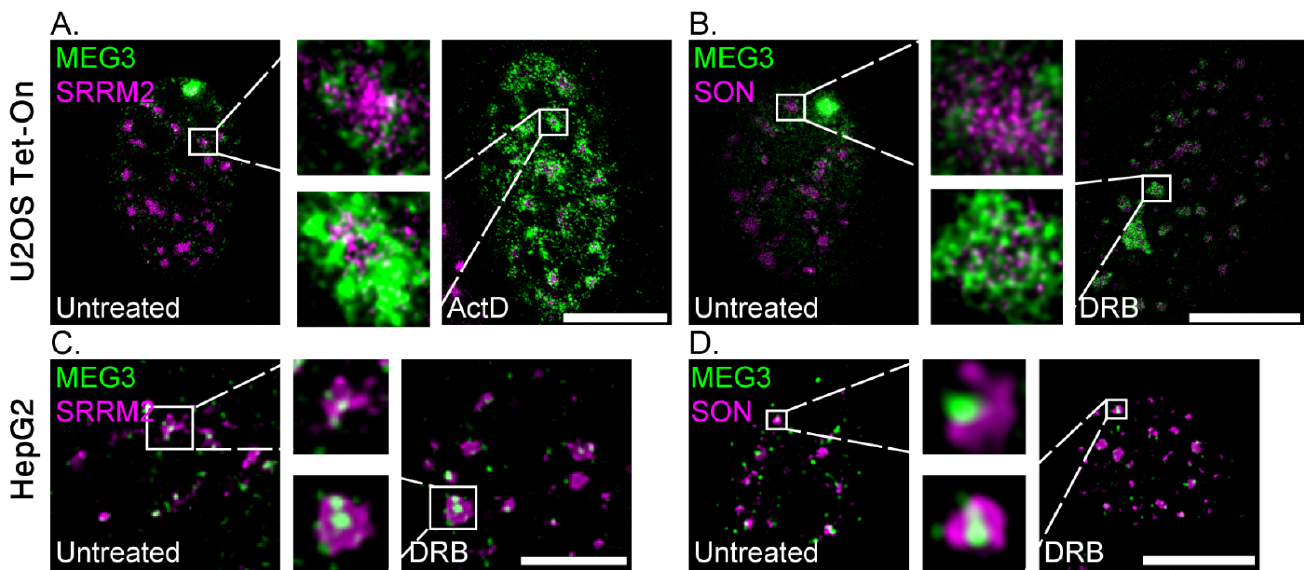
Figure 8. MEG3 can localize to the core of the nuclear speckle under transcription inhibition. ( A , B ) STED super-resolution imaging of RNA FISH to MEG3-MS2 RNA (probe to MS2 in green) in U2OS Tet-On cells labeled with ( A ) SRRM2 or ( B ) SON staining (magenta), in untreated cells (left) or with ActD/DRB (2 hrs) treatments, respectively (right). Enlargements of boxed areas are in the center. ( C,D ) Confocal imaging of RNA FISH to MEG3 lcRNA in HepG2 cells labeled with ( C ) SRRM2 or ( D ) SON (magenta), in untreated cells (left) or with DRB treatment (2 hrs, right). Enlargements of boxed areas are in the center. Bars = 10 μ m.